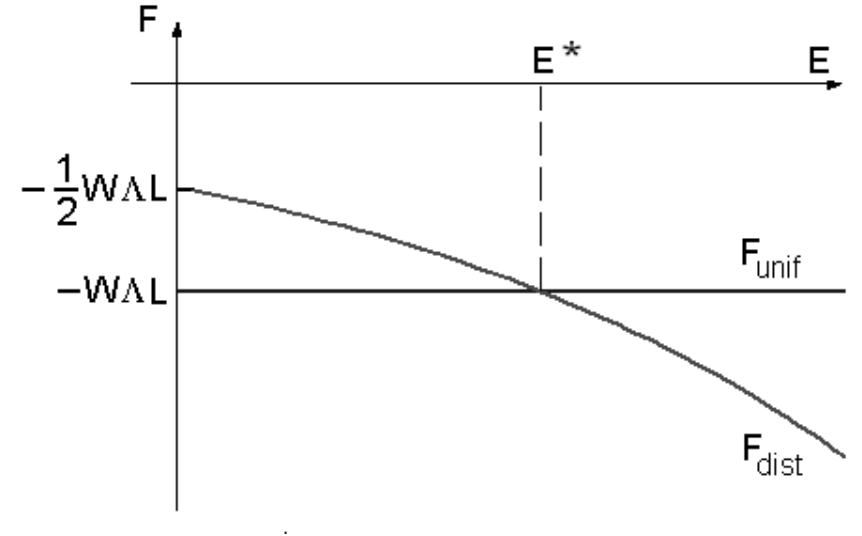
Figure 2 . Comparison of the free energy behaviours in the case of the uniform configuration and for the distorted